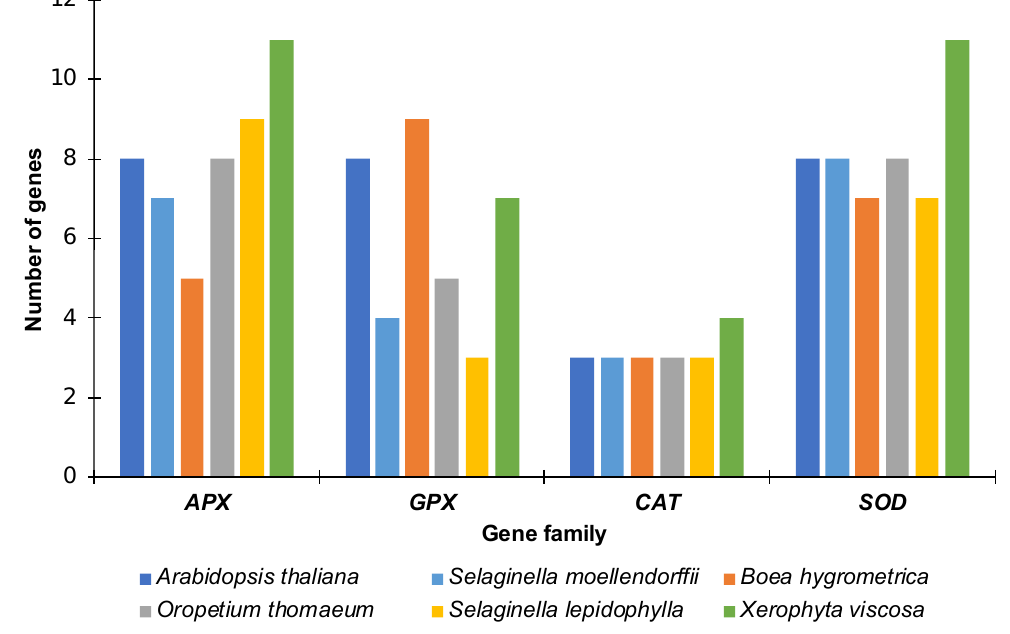
Figure 1. Number of genes for each family in the species analyzed. The number of genes identified for ascorbate peroxidase (APX), glutathione peroxidase (GPX), catalase (CAT) and superoxide dismutase (SOD) proteins in each species along with the number of genes found in Arabidopsis thaliana are represented as a bar